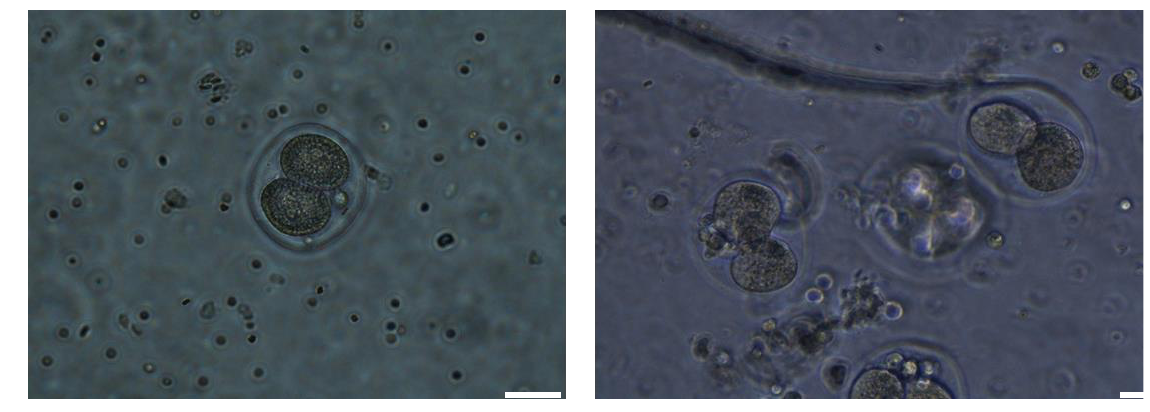
Figure 7 . Viable embryos after 24h of cultivation (bar=50µm).